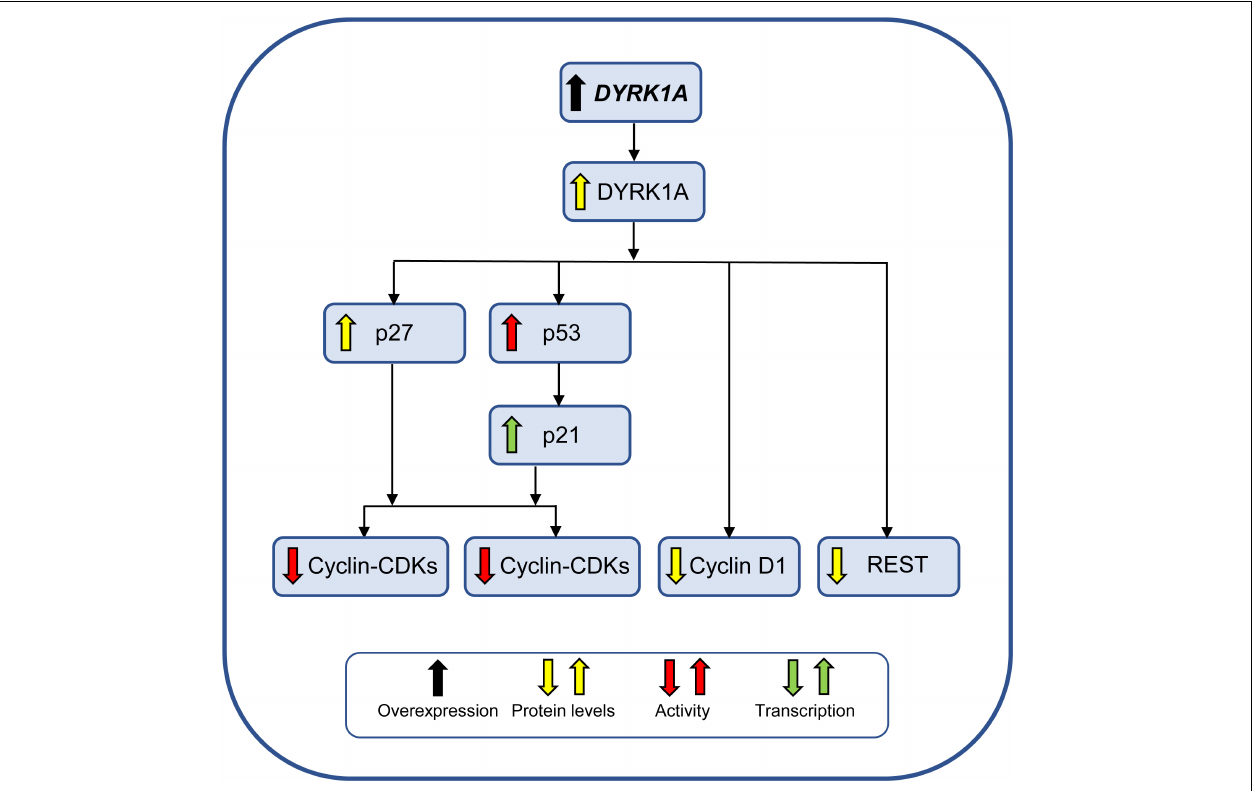
FIGURE 4 | Effect of DYRK1A overexpression on NPC proliferation. DYRK1A impairs proliferation of NPCs by reducing the activity of different cyclin-CDKs and by reducing the levels of REST, a key regulator of pluripotency and neuronal differentiation. See text for further explanation. Abbreviations: DYRK1A, dual-specificity tyrosine phosphorylation-regulated kinase